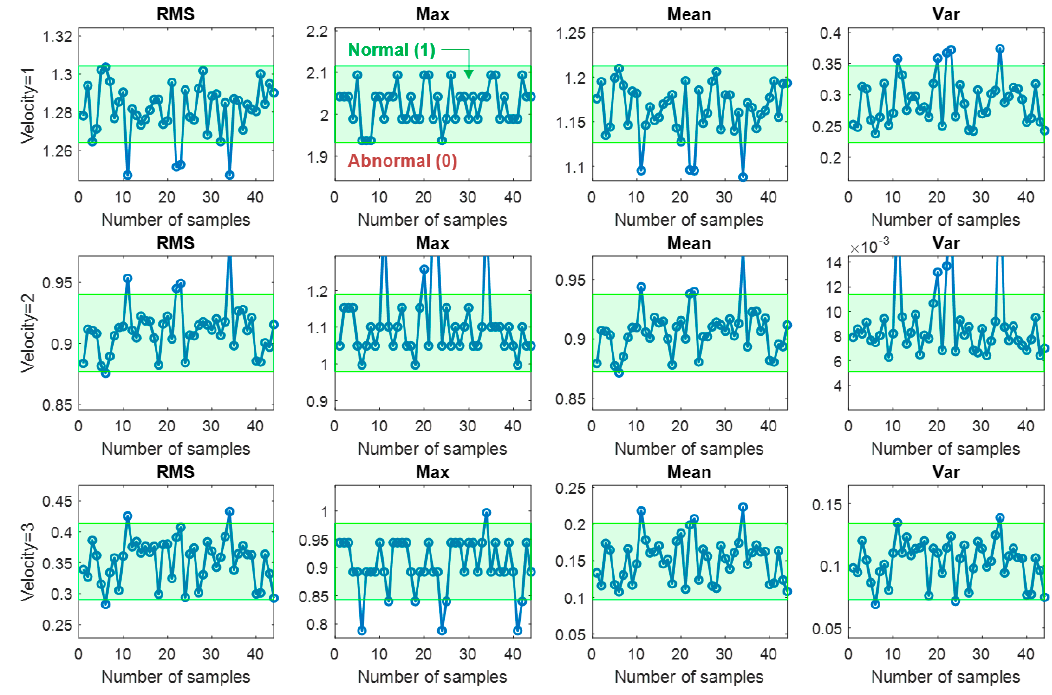
Figure 4. Feature transformation into the binary state during the open operation.